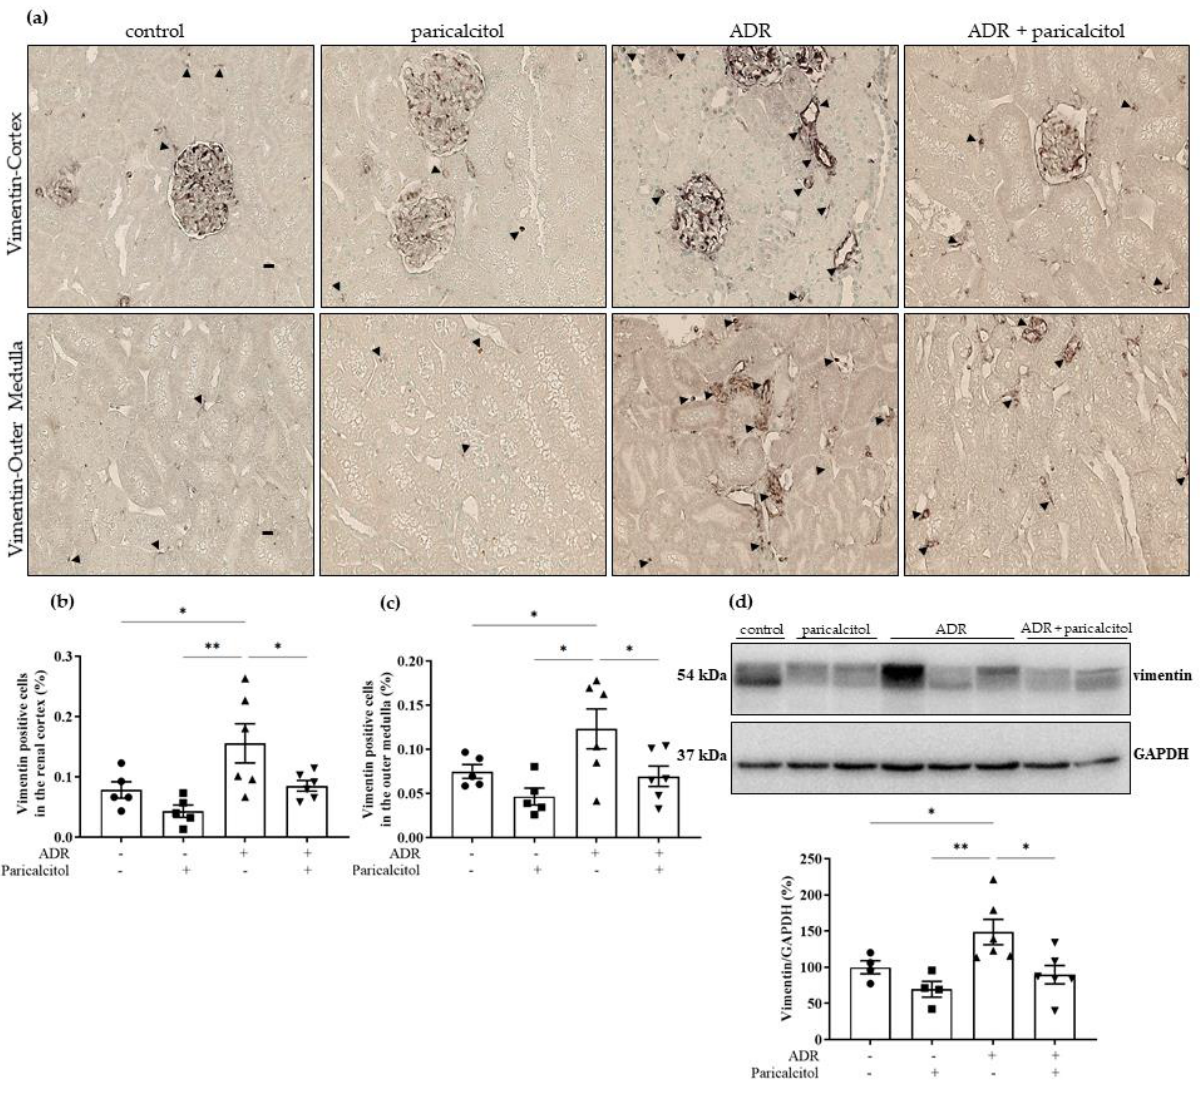
Figure 7. ( a ). The immunolocalization of vimentin in all renal compartments. The arrowheads indicate the vimentin-positive expression in the tubulointerstitial compartments. ( b ). Percentual of vimentin-positive cells in the renal cortex ( c ). Percentual of vimentin-positive cells in the outer medulla. Immunohistochemical data are expressed as the mean ± SEM. Scale bar = 20 µ m, n = 5–6. ( d ). Densitometric ratios among vimentin and GAPDH were calculated, and data were expressed compared with the control group. The control value was designated as 100%. Data are expressed as mean ± SEM. n = 4–6 for each group. Data from the control (dots), paricalcitol (squares), ADR (up triangles), and ADR + paricalcitol (down triangles) groups. * p < 0.05; ** p < 0.01; *** p < 0.001.